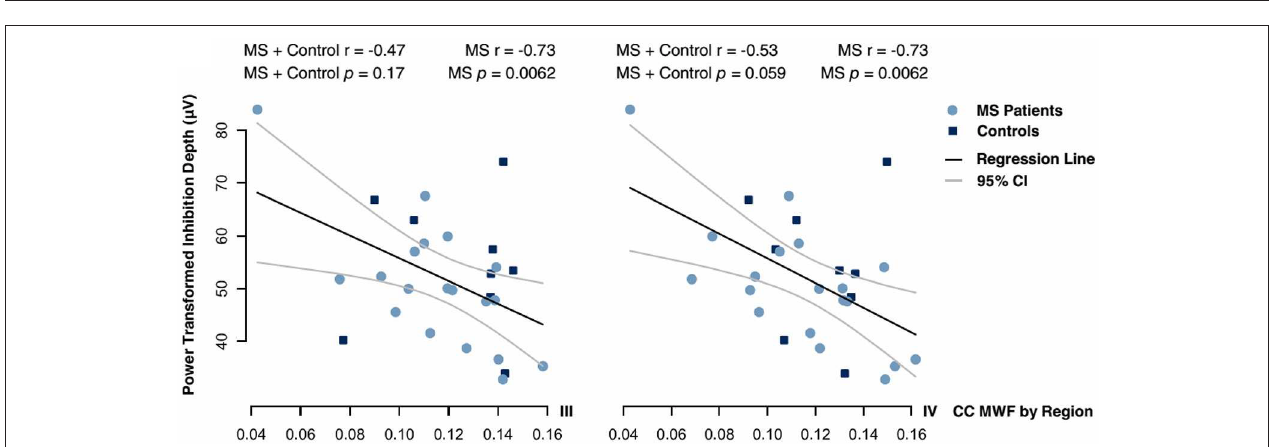
FIGURE 6 | Onset latency and duration of the ipsilateral silent period (iSP), as measured by transcranial magnetic stimulation, were correlated with MS clinical measures. Correlation coefficients and p values were calculated based on Pearson correlation and adjusted for multiple comparisons by the Holm-Bonferroni method.